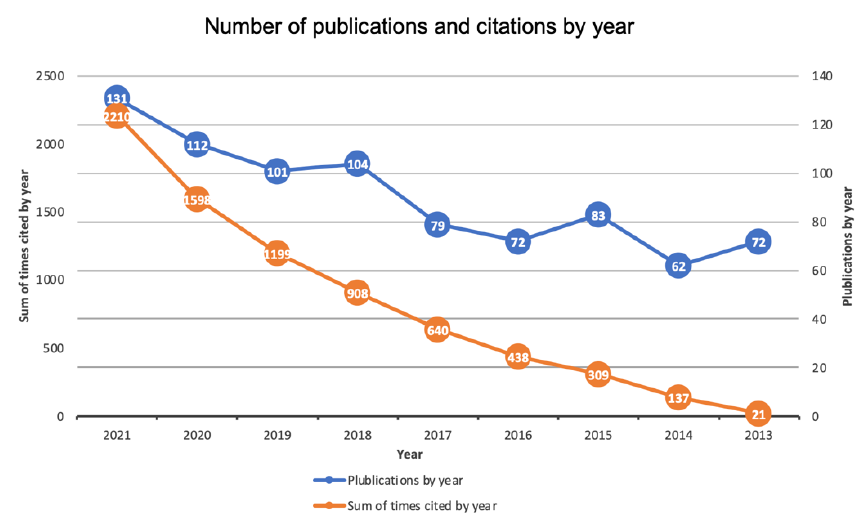
Figure 2. Temporal evolution of the number of publications and total number of citations.